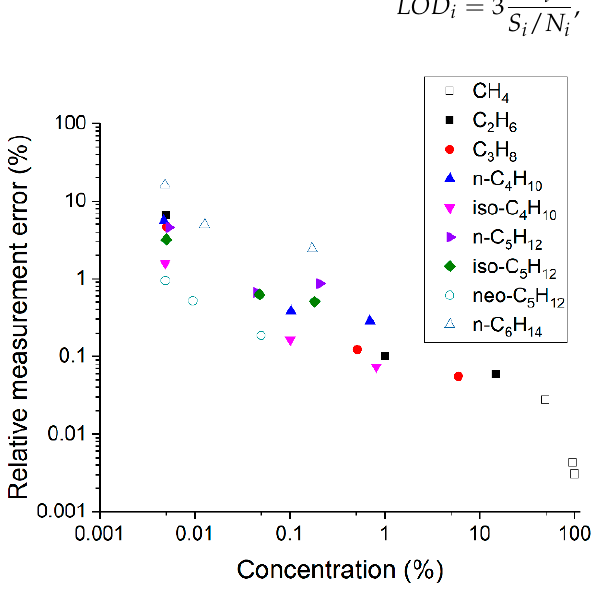
Figure 5. Relative measurement errors of alkanes at different concentrations.